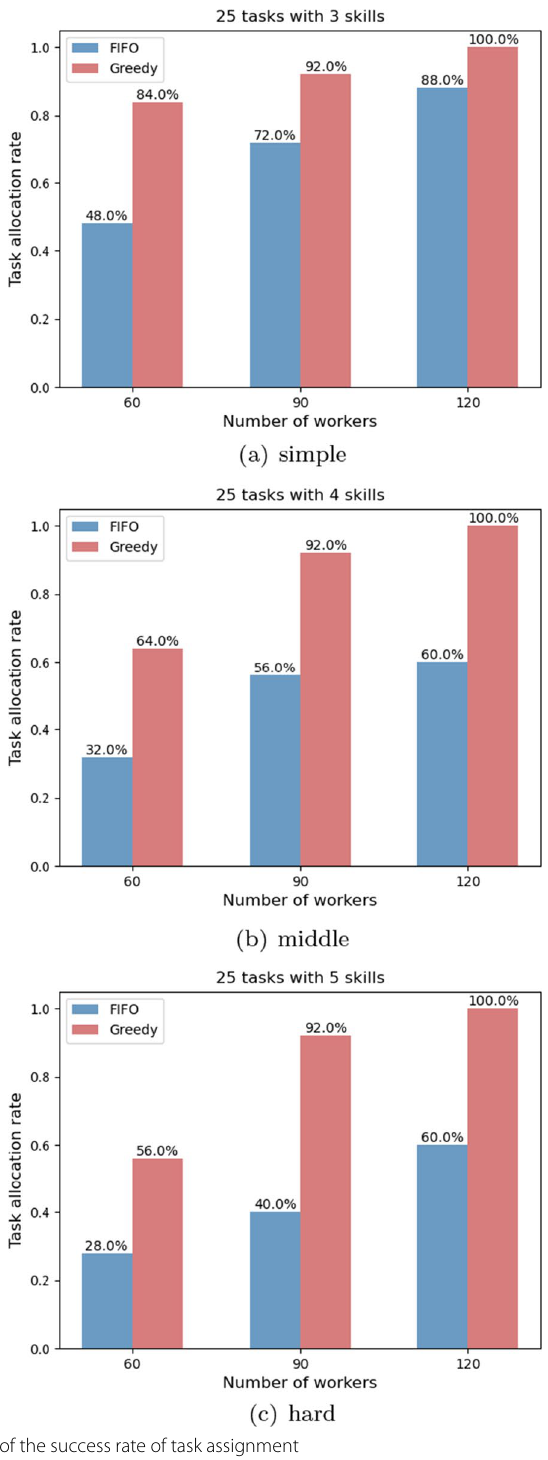
Fig. 8 Comparison of the success rate of task